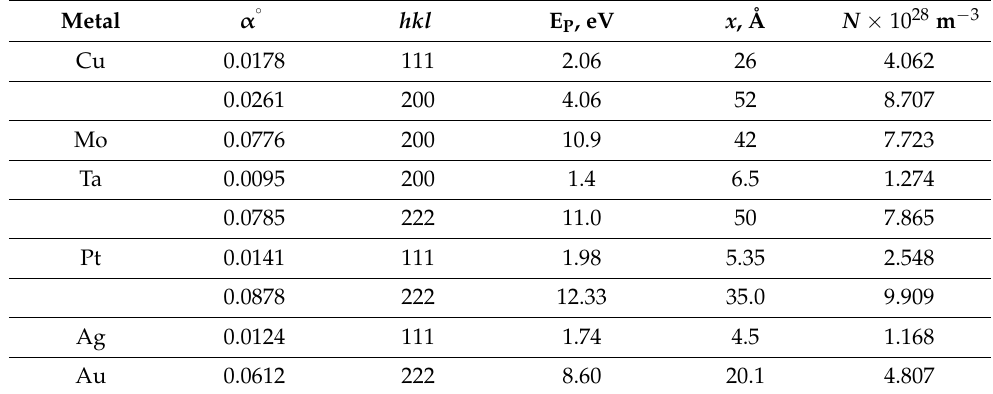
Table 3. Experimental data on X-ray diffraction and calculation results for metals [29].